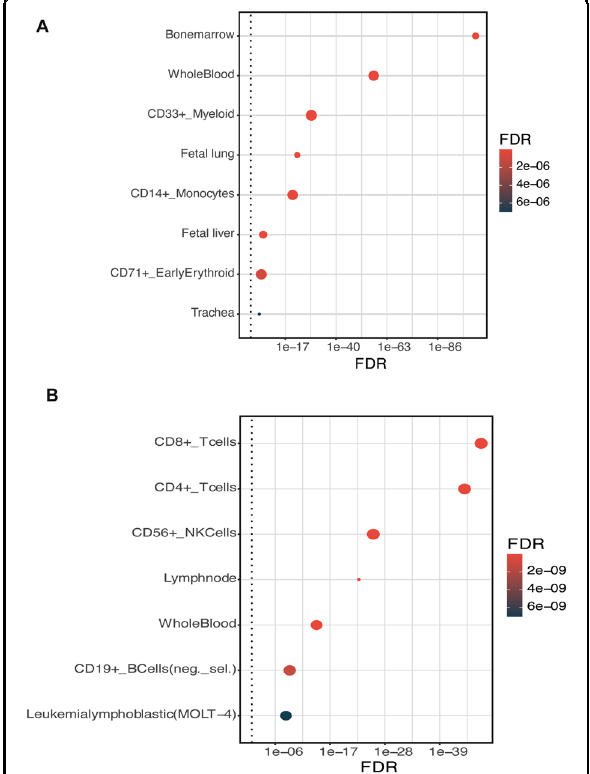
Fig. 6 PBMC-based gene signatures show association with subset of immune cells in coronavirus-infected patients. A , B Enrichment (hypergeometric test using hypeR 57 ) of subsets of immune cell genes in multiple BioGPS — gene portal system 36 using CoV-Up-gene signature ( A ) and CoV-Down-gene signature ( B